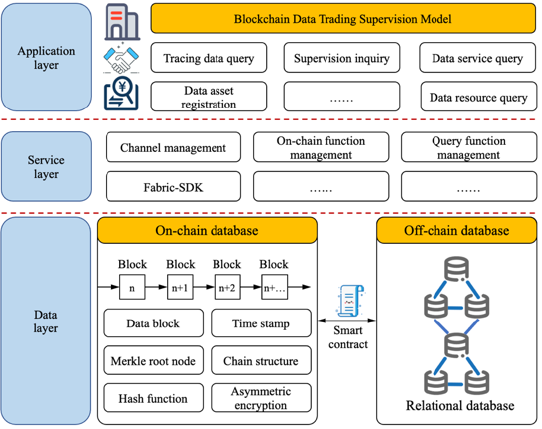
Figure 8. On-chain layer structure of data trading supervision model.